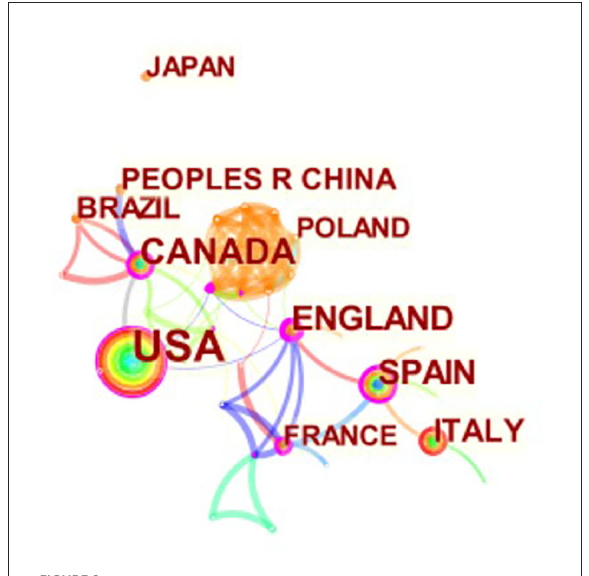
FIGURE2 Map of countries related to CVD with frailty from 2000 to